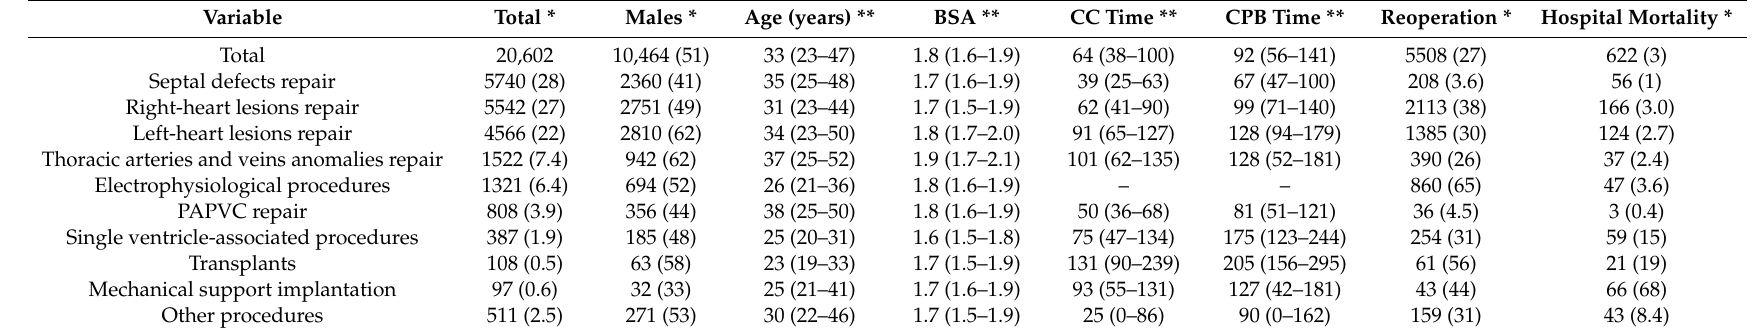
Table 1. Demographics and patient